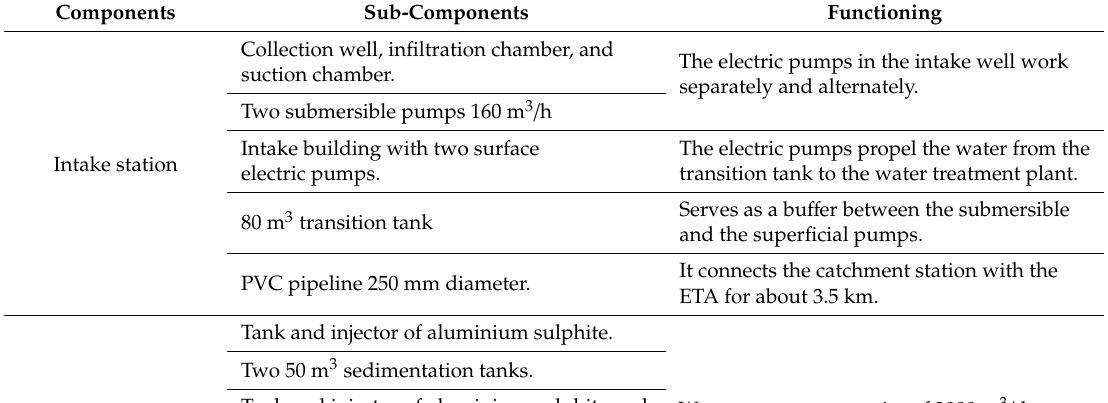
Table A1. Components of the piped water supply infrastructure of